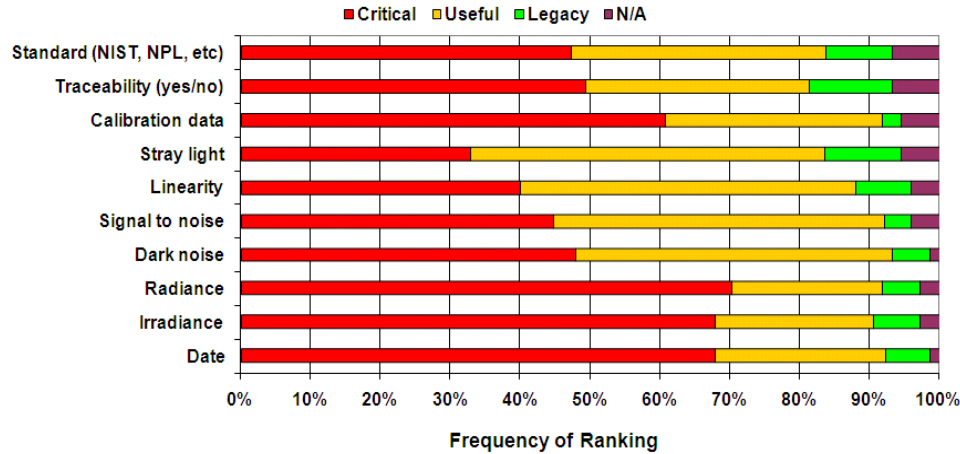
Figure 3. Frequency of criticality ranking for ―calibration‖ metadata ( n =